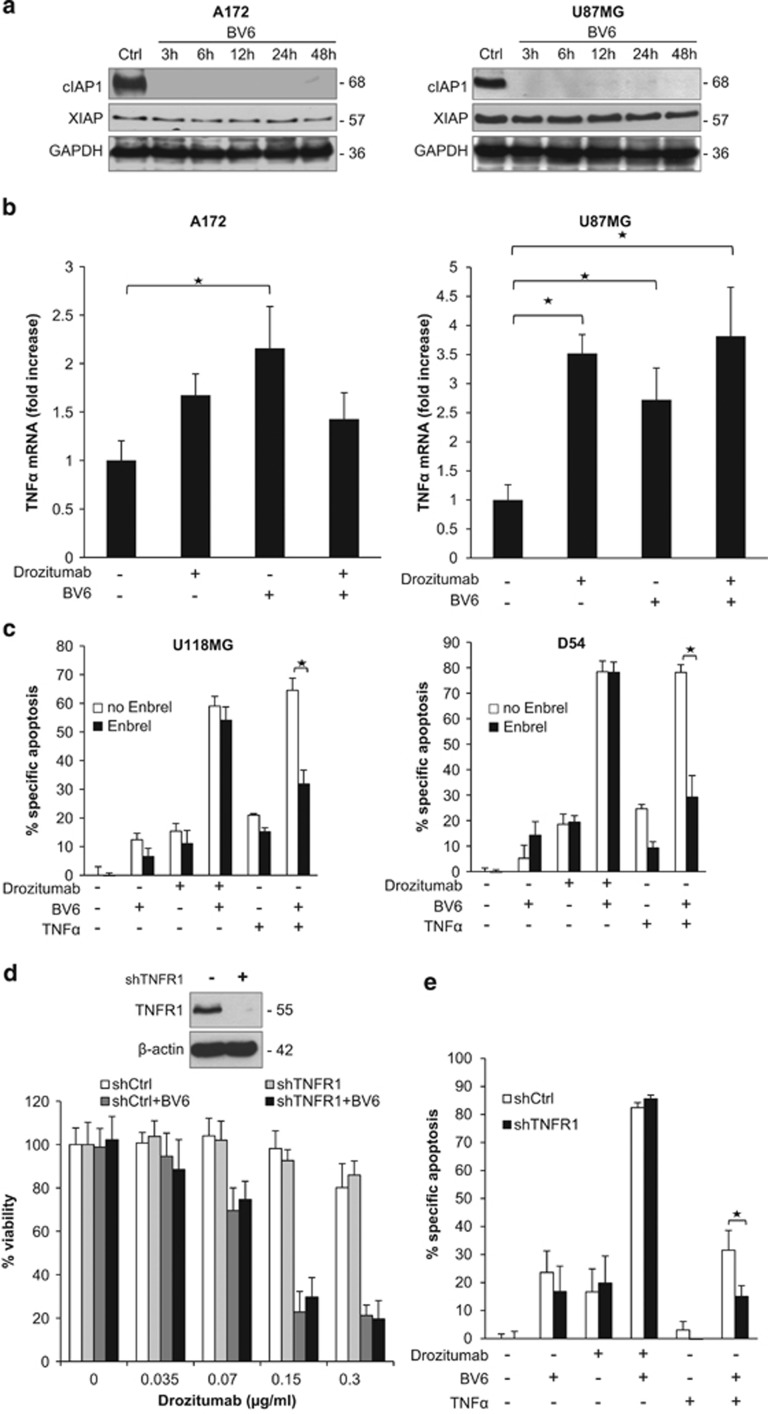
TNFα is dispensable for BV6- and Drozitumab-induced apoptosis. (a) Glioblastoma cells were treated for indicated times with 3 μM (A172) or 4 μM (U87MG) BV6. Expression of cIAP1 and XIAP was analyzed by western blotting. GAPDH served as loading control. (b) Glioblastoma cells were treated for 3 h with 0.3 μg/ml (A172) or 5 μg/ml (U87MG) Drozitumab and/or 3 μM (A172) or 4 μM (U87MG) BV6. TNFα mRNA expression was determined by RT-PCR analysis. Fold change of TNFα mRNA levels is shown. Data represent mean + S.E.M. of three independent experiments performed in triplicate; *P<0.05. (c) Glioblastoma cells were pretreated or not for 1 h with 100 μg/ml Enbrel and then treated for 72 h with Drozitumab at 0.3 μg/ml (D54) or 10 μg/ml (U118MG) and/or BV6 at 1 μM (U118MG) or 2 μM (D54). Apoptosis was determined by FACS analysis of DNA fragmentation of propidium iodide-stained nuclei. Treatment with 5 ng/ml TNFα and BV6 for 72 h served as positive control for Enbrel. Data represent mean + S.E.M. of three independent experiments performed in triplicate; *P<0.05. (d and e) A172 cells were transduced with shRNA vector against TNFR1 (shTNFR1) or control sequence (shCtrl). Expression of TNFR1 was analyzed by western blotting (d, upper left panel). A172 cells were treated with indicated concentrations of Drozitumab and/or BV6 for 72 h, cell viability was determined by MTT assay and is expressed as percentage of untreated controls (d, lower left panel). A172 cells were treated with indicated concentrations of Drozitumab and/or BV6 for 72 h and apoptosis was determined by FACS analysis of DNA fragmentation of propidium iodide-stained nuclei (e). Treatment with 5 ng/ml TNFα and 3 μM BV6 for 72 h served as positive control for TNFR1 knockdown. In d and e, data represent mean + S.E.M. of three independent experiments performed in triplicate; *P<0.05